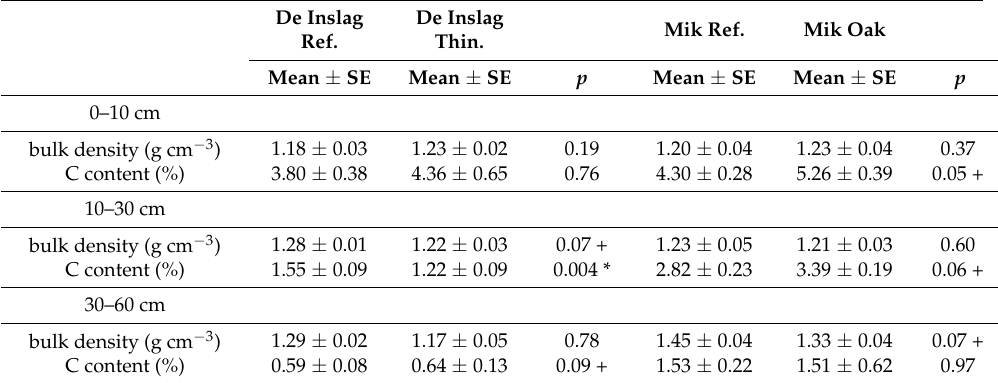
Table 4. Characteristics of the mineral soil for each soil layer in each investigated stand. The star (*) indicates the statistically significant difference between stands at p < 0.05, the plus (+) indicates 0.05 < p < 0.10. De Inslag De Inslag Mik Ref. Mik Oak Ref. Thin.